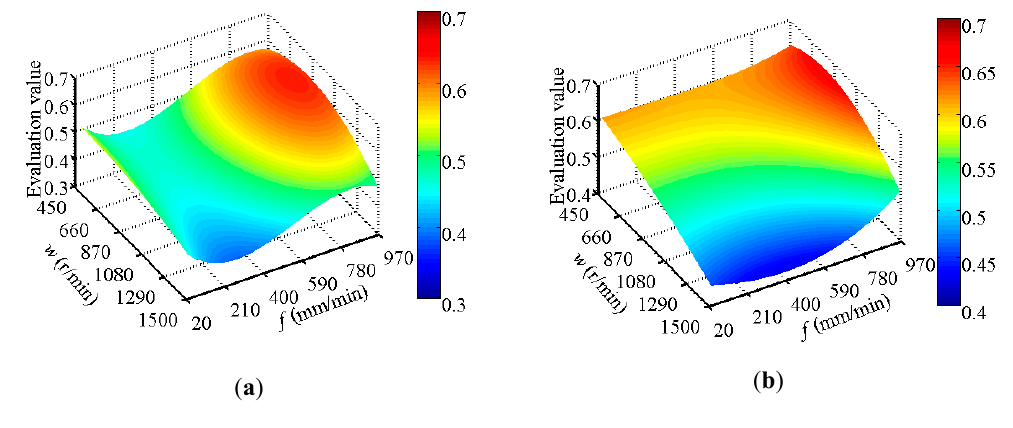
Figure 15. Surface graphs of comprehensive evaluation function: ( a ) Up-beating ( m = 1); ( b ) down-beating ( m = − 1).